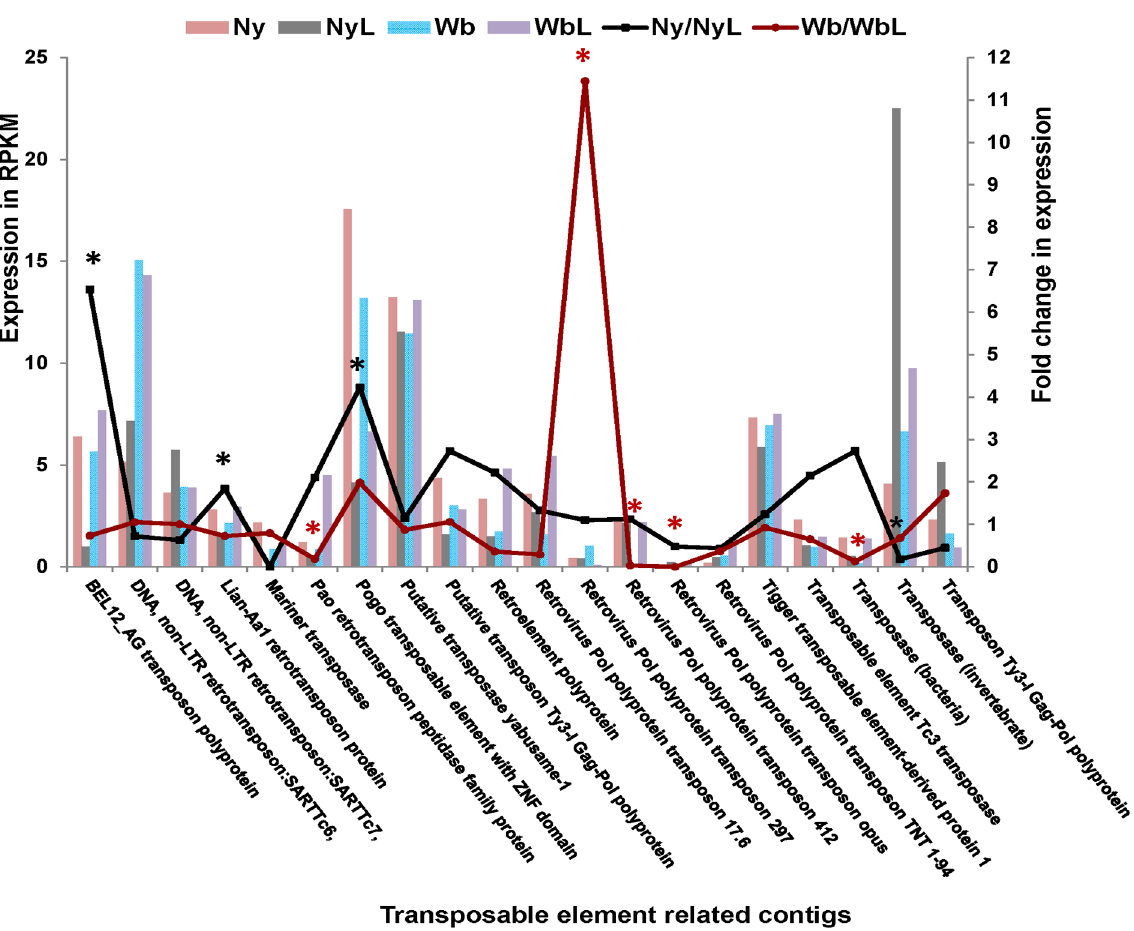
Fig 9. Transposon expression levels, in Ca . Liberibacter asiaticus (CLas) infected compared to uninfected Asian citrus psyllid (ACP) adults (Wb x WbL) and nymphs (Ny x NyL). The x- axis shows contigs representing different transposable element categories that were identified using the search terms, as described in the Methods section. Normalized expression in reads, per kilobase per million mapped reads (RPKM) of the transposable elements, is plotted on the primary y-axis for: uninfected nymphal instars (Ny-red bars), infected nymphal instars (NyL- grey bars), uninfected adults (Wb- blue bars), and infected adults (WbL-purple bars). The fold-change response to CLas infection is plotted on the secondary y- axis. The pairwise comparisons between infected and uninfected nymphal instars (NyL/Ny- Black line), and infected and uninfected adults (Wb/WbL-red line), are indicated by the line graphs. Significantly different levels of transcript expression ( P > 0.05) ( * asterisk) are shown for infected and uninfected nymphs (black asterisk), and for infected and uninfected adults (red asterisk).